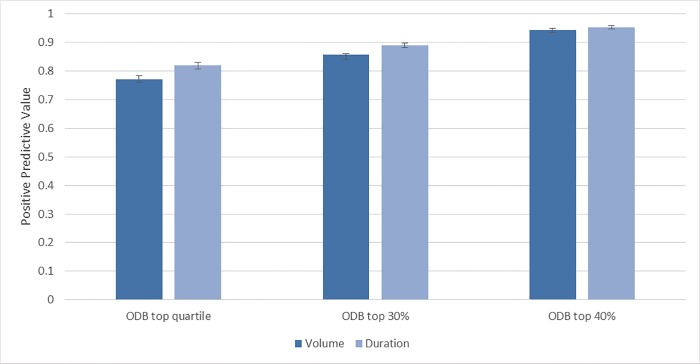
Positive Predictive Values, with 95% confidence intervals, comparing the highest quartile from Xponent to ODB to identify high volume and high prolonged duration prescribers.